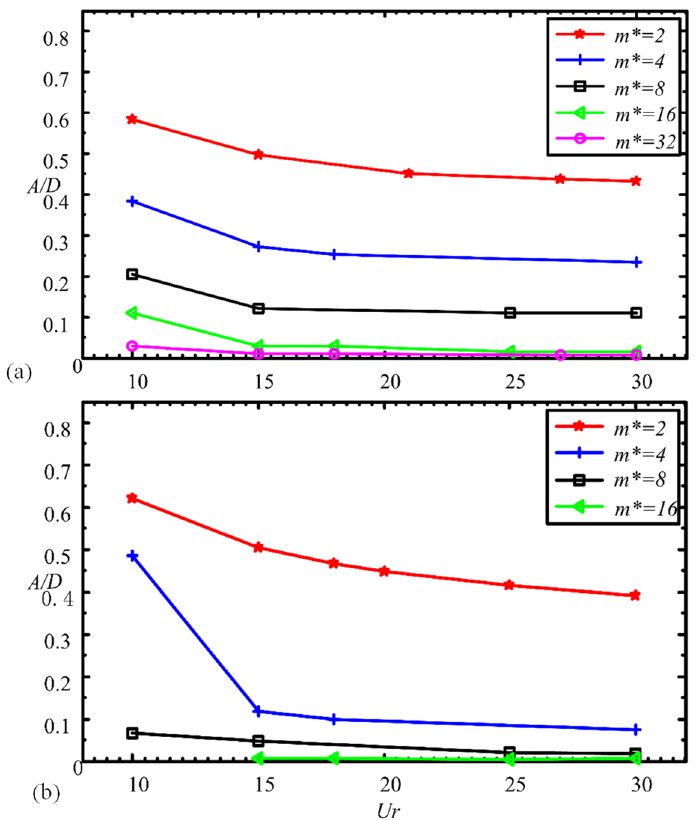
Figure 8. Effect of mass ratio m * on vibration amplitude A/D . ( a ) L/D = 3.0 and ( b ) L/D = 1.5. ζ = 0 .